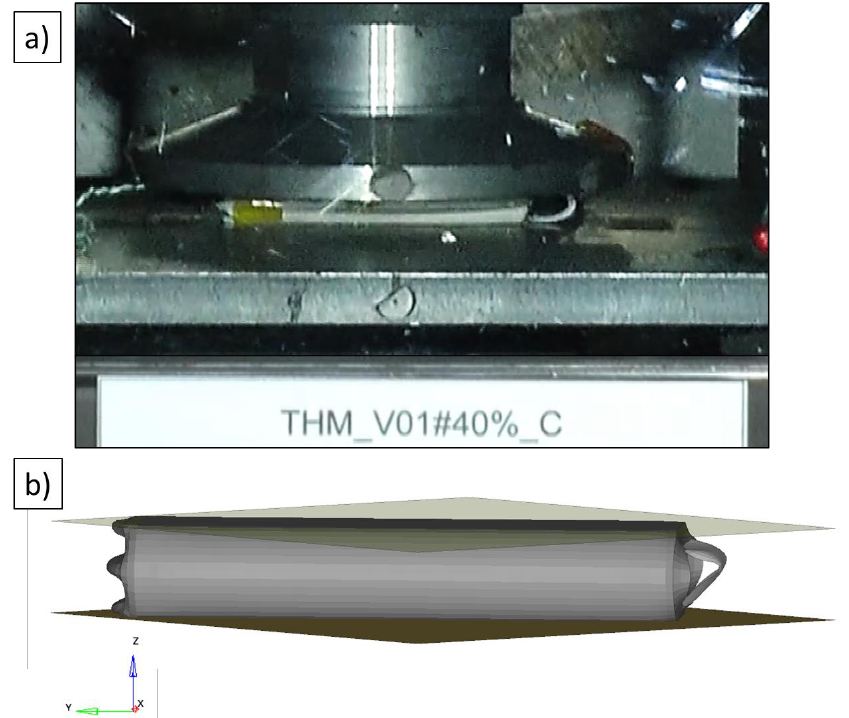
Figure 17. Deformed cell ( a ) and the corresponding FEM model ( b ).